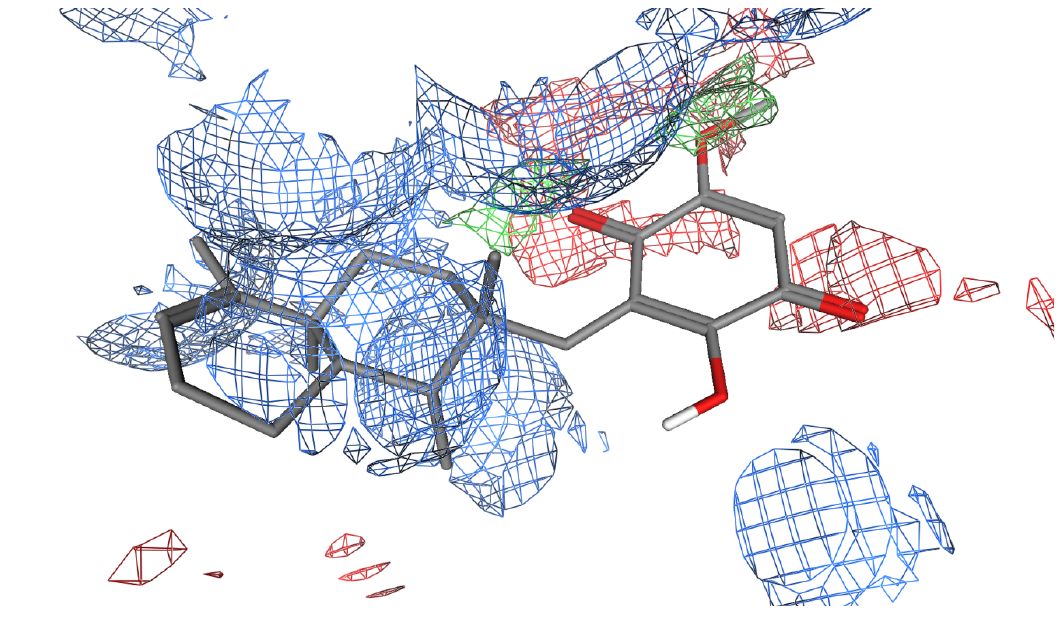
Figure 5. Electrostatics maps (Hydrophobic; green, Hydrogen bond acceptor; red and Hydrogen bond donor; blue) for 1 (stick representation) bound at the proposed CTD binding